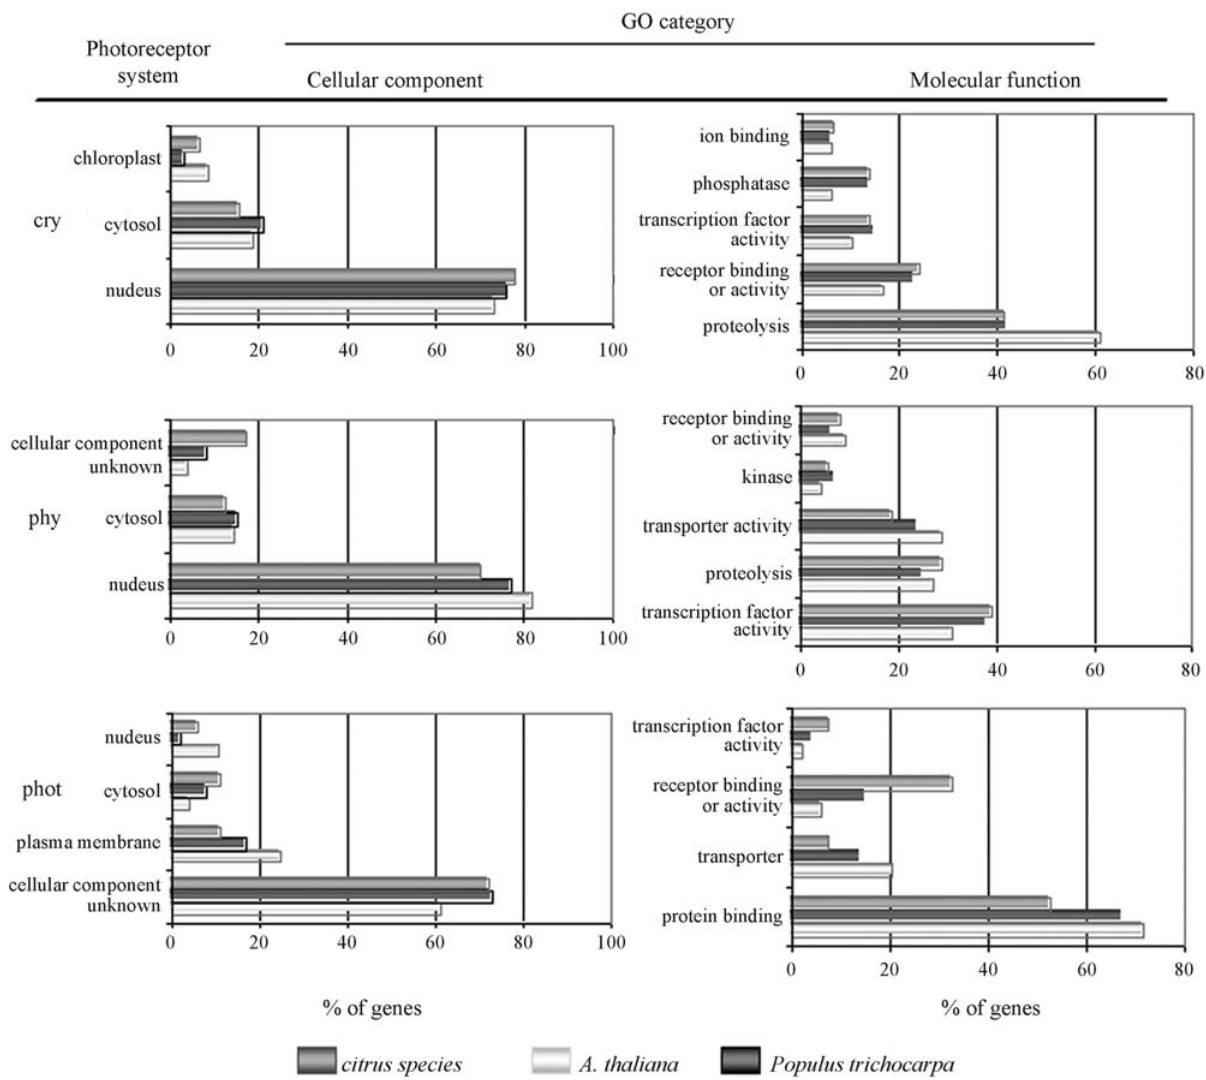
Figure 1 - Functional classification of citrus transcripts associated to photoperception and light signal transduction based on gene ontology (GO) catego- ries in comparison to Populus trichocarpa transcriptome and Arabidopsis thaliana proteome. Photoreceptor systems are indicated by the columns: cry; cryptochrome, phy; phytochrome and phot; phototropin. Assignments are based on the data available at the TIGR Arabidopsis thaliana Gene Index ver- sion